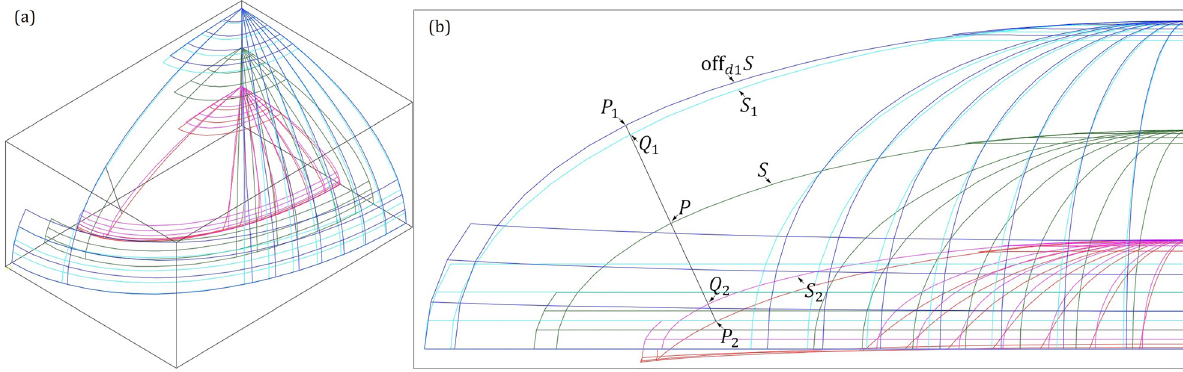
Figure 3: The arrangement of points and surfaces S , S 1 , S 2 , S off d 1 , S off d 2